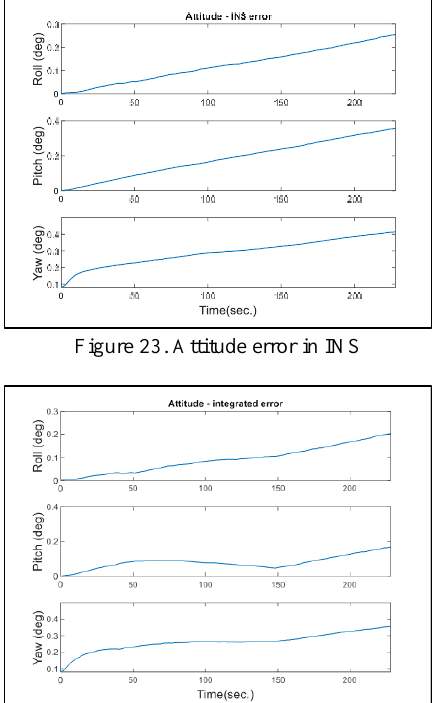
Figure 24. Attitude error in the integrated system